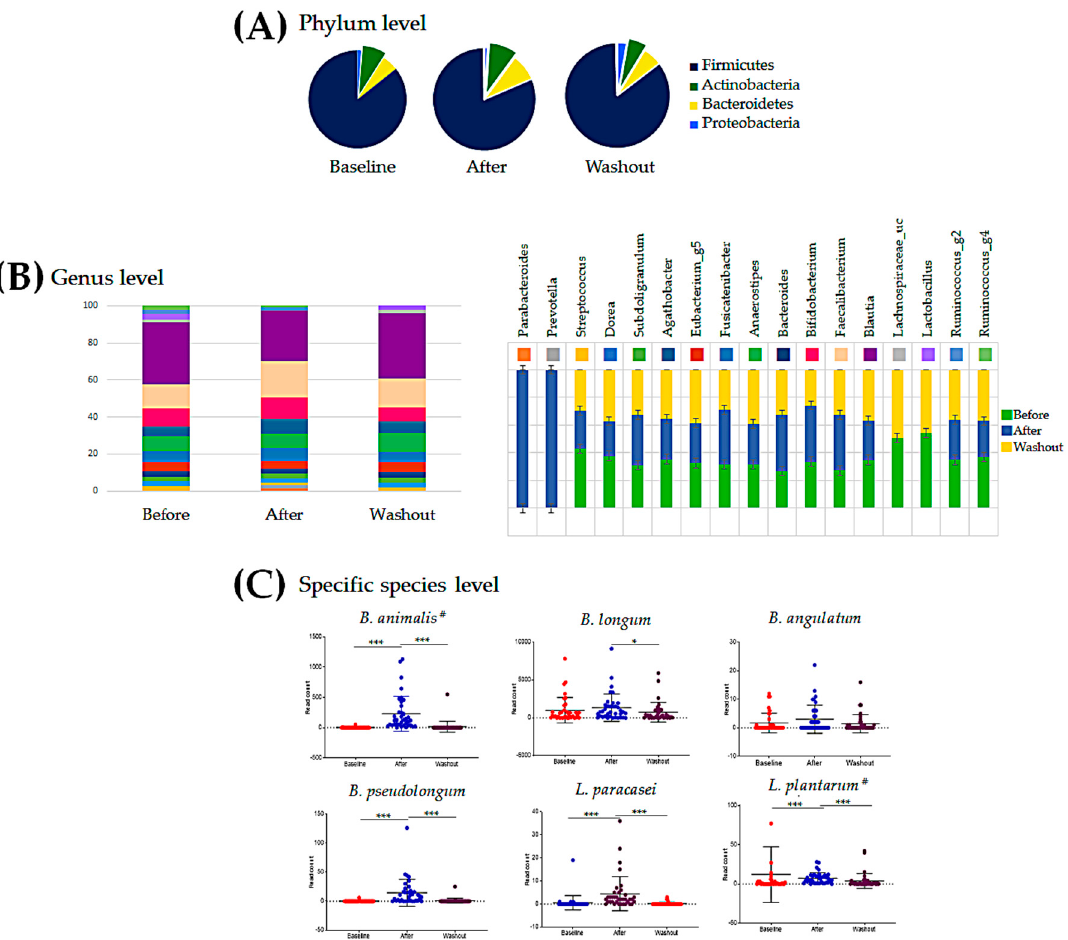
Figure 2. Relative abundance of intestinal microbial phyla ( A ), genera ( B ), and species ( C ) in 37 participants based on 16S rRNA analysis. Numbers indicate the relative contribution (percentage) of each microbial level. * p < 0.05, *** p < 0.005 (paired t -test and Wilcoxon rank-sum test). In ( C ), Crosshatch ( # ) is indicated for the bacteria contained in the synbiotic drink.